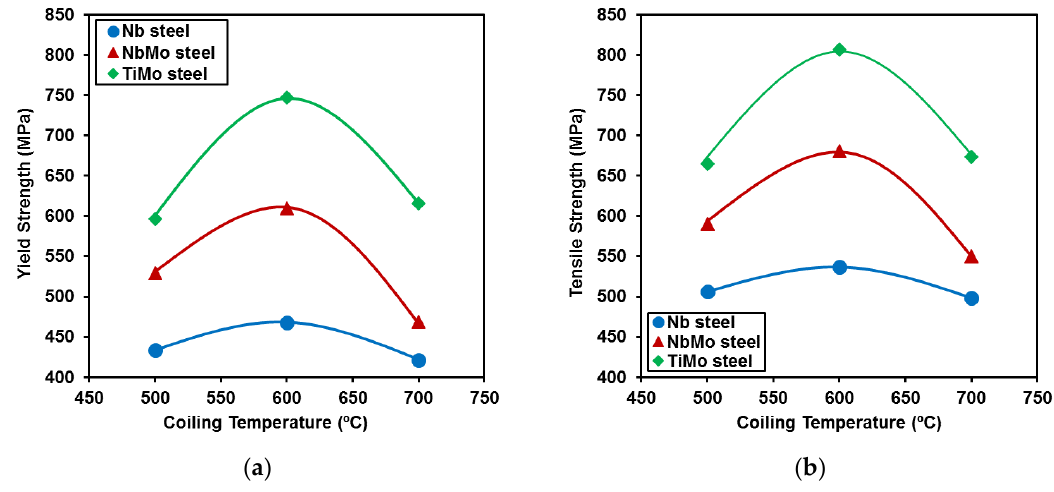
Figure 8. Evolution of the: yield strength ( a ); and tensile strength ( b ) as a function of coiling temperature. Table 3. Yield Strength ( YS ), Tensile Strength ( TS ), Elongation (%) and Area Reduction (%) values for the TiMo, NbMo and Nb steels and coiling temperatures of 700 ◦ C, 600 ◦ C and 500 ◦